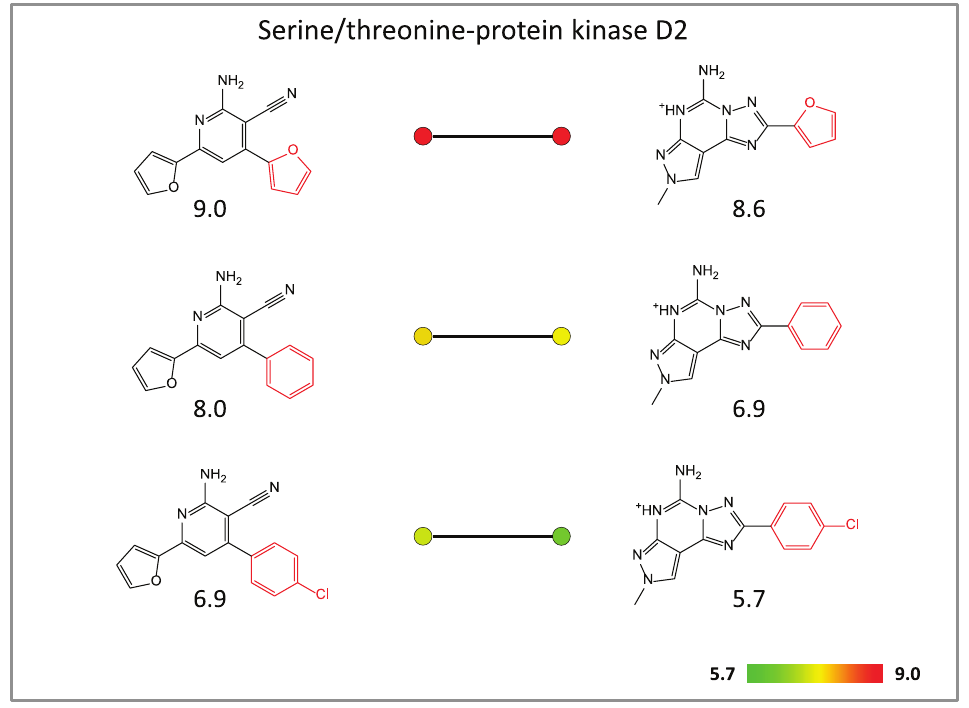
Figure 2. SAR transfer series. An exemplary target-based SAR transfer series is shown. Compound pairs are arranged in the order of increasing potency (from the bottom to the top). Potency progression is monitored by corresponding pairs of color-coded dots using a continuous color spectrum from green (lowest potency value (pK = 5.7) in the compound data set), over yellow to red (highest potency value; i pK = 9.0). The pK value of each compound is provided. The core structures are drawn in black and the substituents in red. The compounds i i are active against serine/threonine-protein kinase D2.